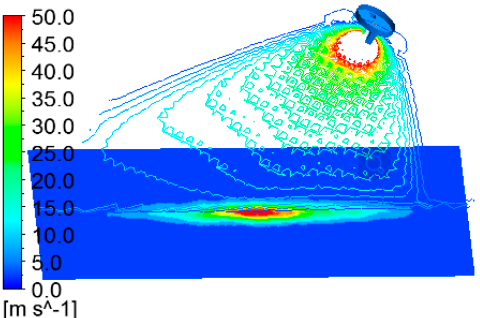
Figure 15. Planar tilted spraying: velocity contours in the plane X = 0 overlaid with static coating film thickness on the target.